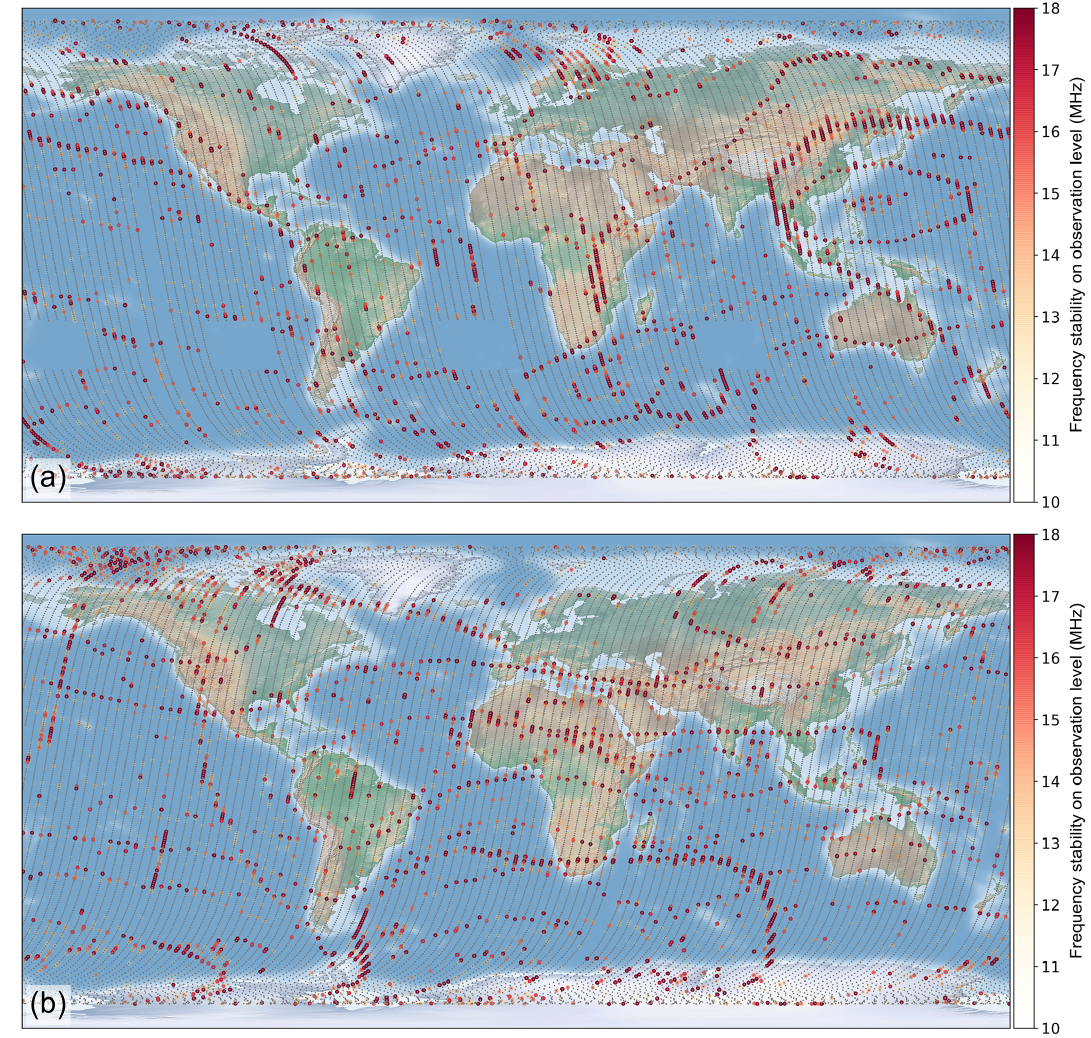
Figure 6. Geolocation of wind observations with enhanced frequency noise for (a) ascending and (b) descending orbits. The plot contains the data from the week between 14 October 2019 (00:00UTC) and 21 October 2019 (00:00UTC) (see also Fig. 4). Each dot corresponds to one observation (12s), whereby the color coding describes the σ f (N = 540 ) . Note that the opacity of the dots also scales with the frequency stability so that observations with σ < 10MHz are not